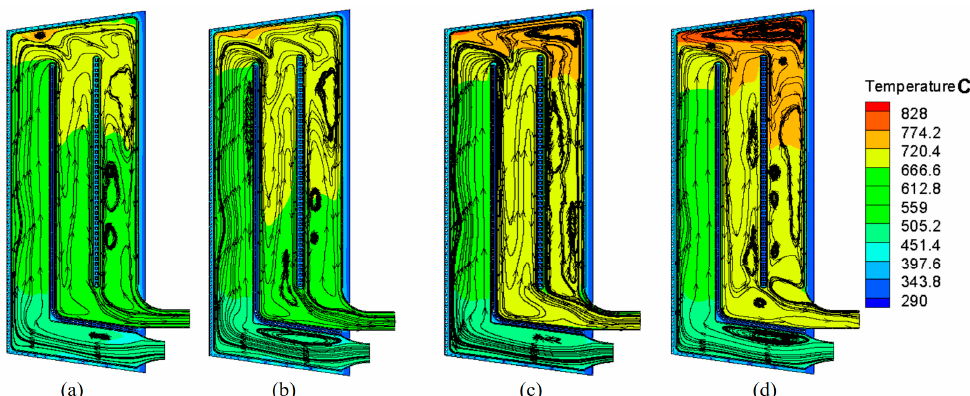
Figure 10. Contour of temperature and streamline for different thermal conductivity of SiC ( a ) 3.5 W/(m ∙ K); ( b ) 2.5 W/(m ∙ K); ( c ) 1.5 W/(m ∙ K); ( d ) 1.0 W/(m ∙ K).